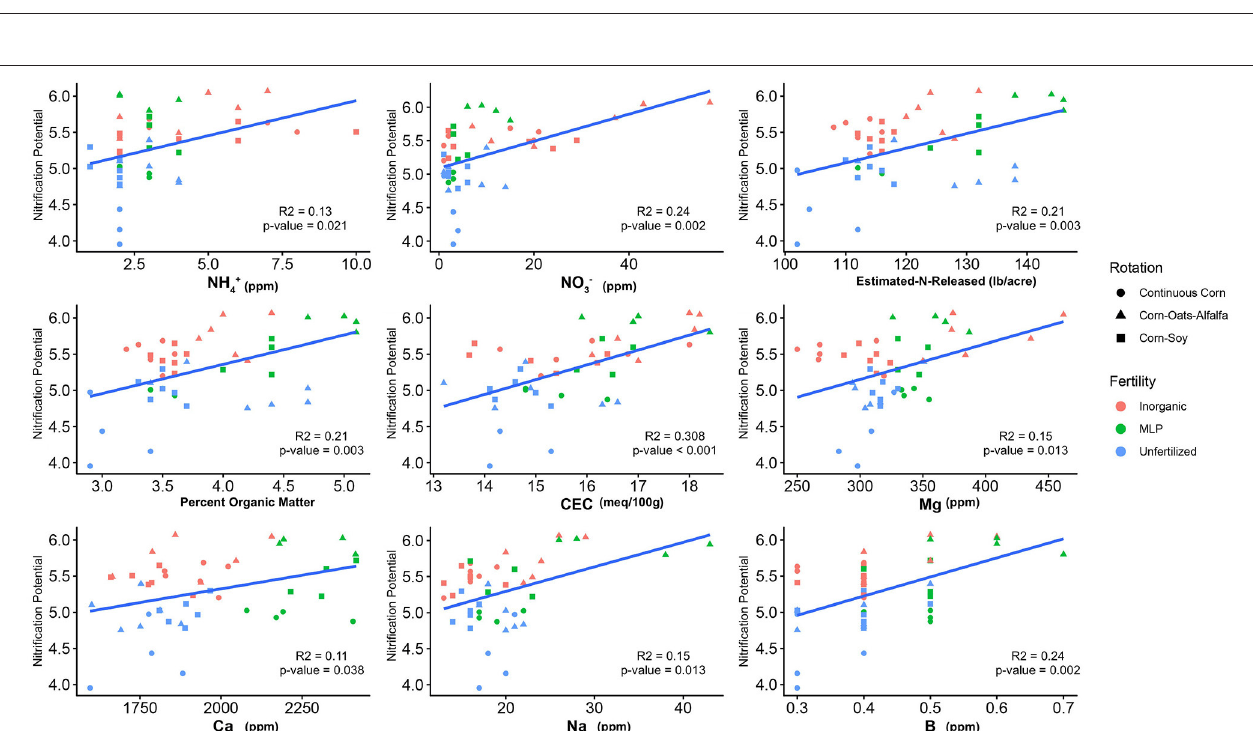
FIGURE 2 | Relationship between nitrification potential and soil edaphic variables. Only edaphic factors which significantly influenced nitrification potential are reported. Model coefficients and P -values are reported in Table 2 .